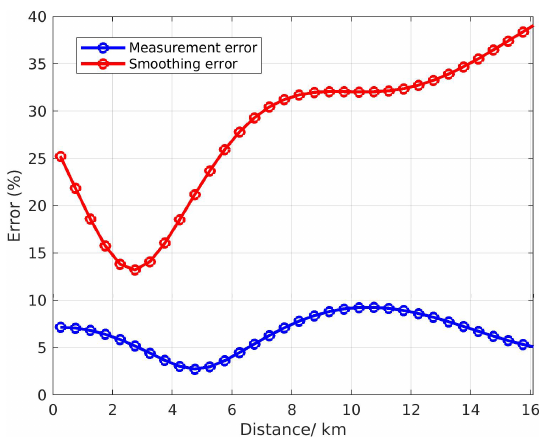
Figure 16. Example of the NO 2 measurement and smoothing er- ror in percentage for 2 July 2018 at 10:42UTC and 25 ◦ azimuthal